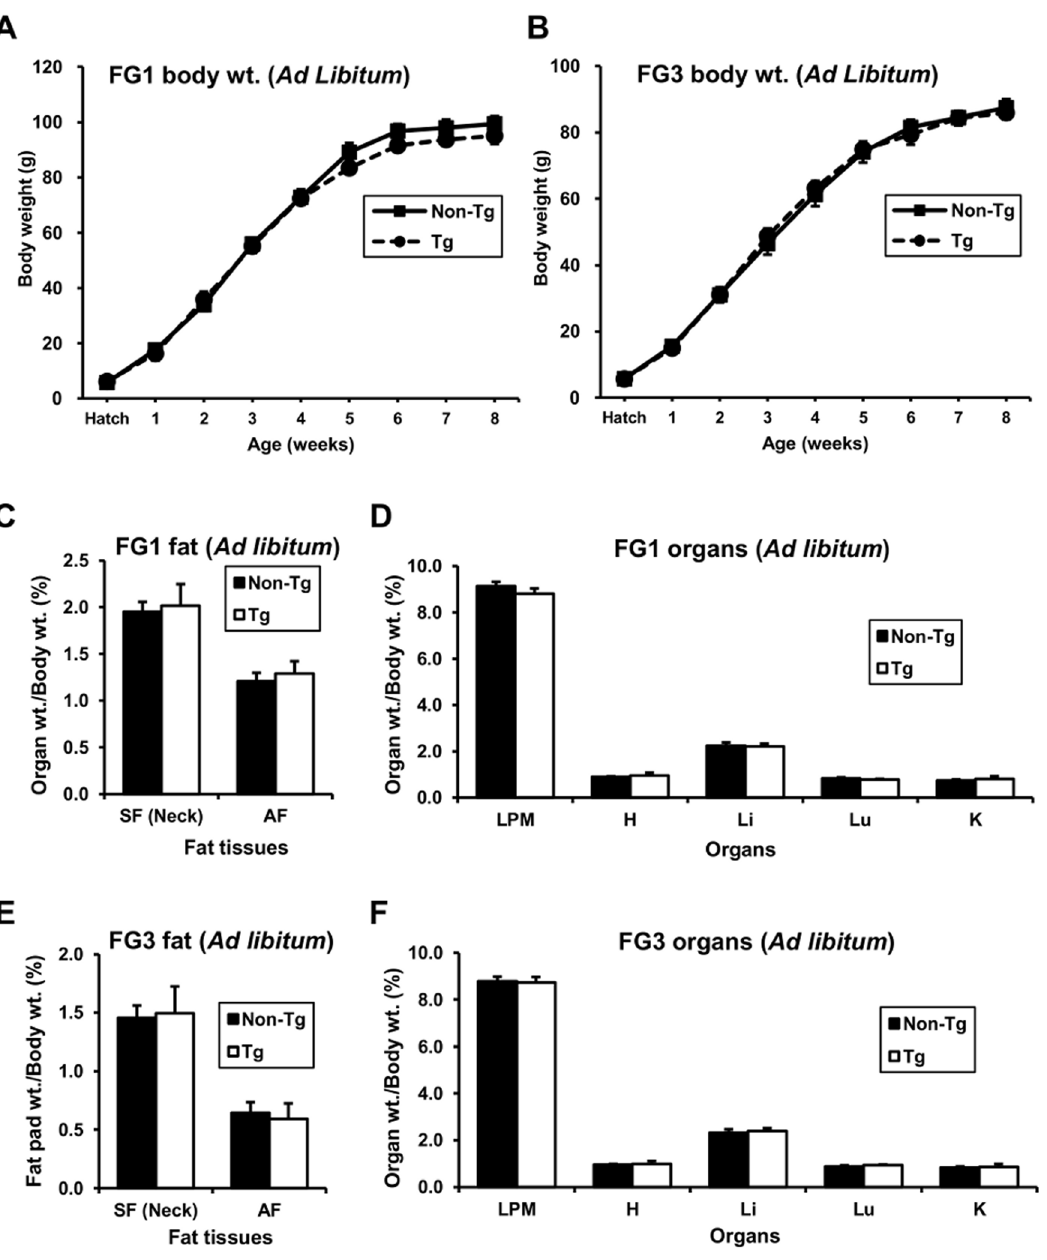
Figure 2. Analysis of growth and organ weights of transgenic and non-transgenic quail fed adlibitum . (A and B) Growth curve of FG1 and FG3 lines of transgenic and non-transgenic quail fed ad libitum . Body weights of male transgenic and non-transgenic quail were measured every week from hatch to 8 weeks of age. (C and D) Organ weights of FG1 quail fed ad libitum . Organ weights were measured and calculated to the percentage of total body weight. There was no difference between transgenic and non-transgenic quail in the tissue and organ weights ( n =5). SF: subcutaneous fat, AF: abdominal fat, LPM: left pectoralis muscle, H; heart, Li: liver, Lu: lung, and K: kidney. (E and F) Organ weights of FG3 quail fed ad libitum . FG3 did not show a difference in organ weight between transgenic ( n =6) and non-transgenic ( n =8) quail under the ad libitum feeding. Values are represented as mean 6 SEM.